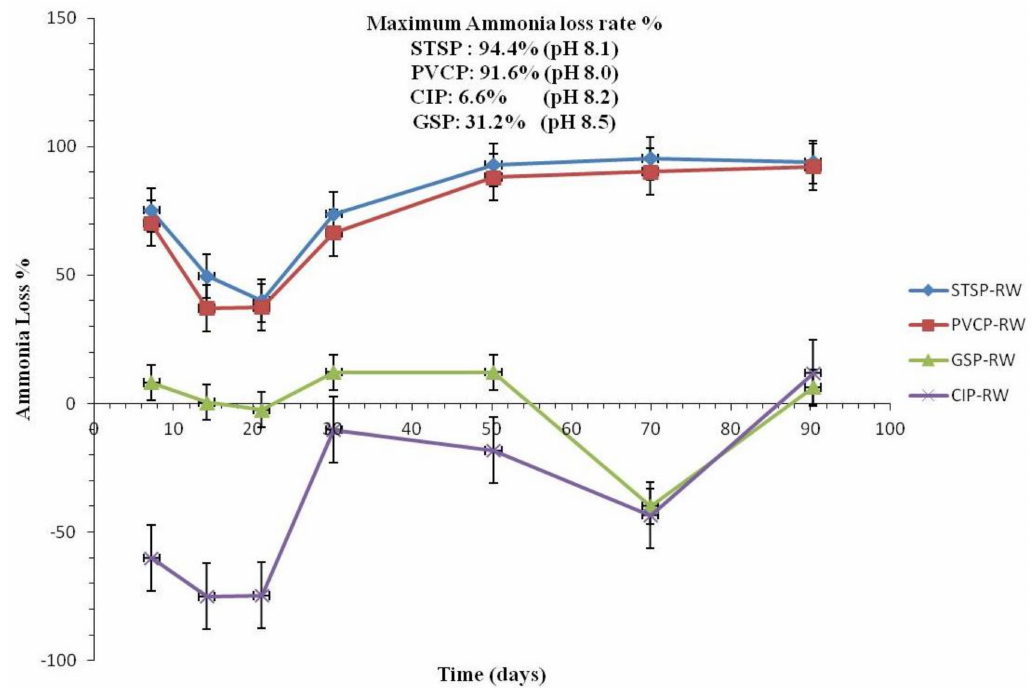
Figure 4. Ammonia loss (%) of RW in stainless steel, polyvinyl chloride, galvanized steel, and cast iron pipes over time with standard error bars.